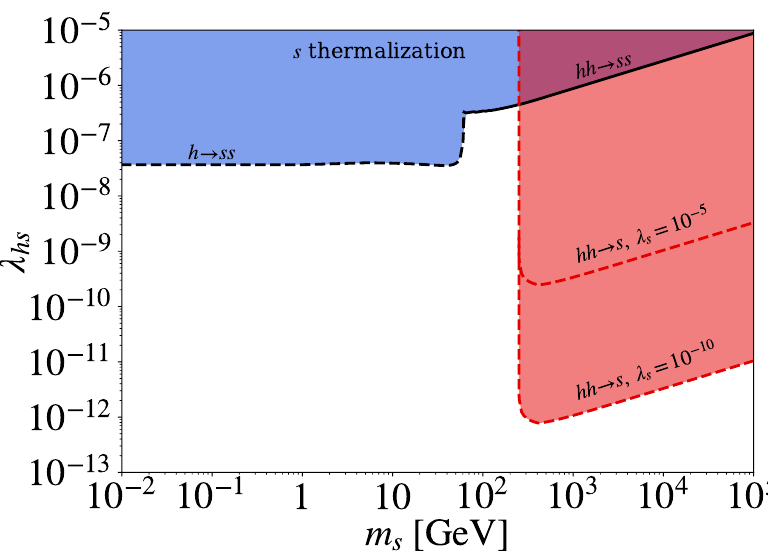
Figure 3 . Upper bounds on (cid:21) hs from non-thermalization of s . In the shaded regions, n s ( T )